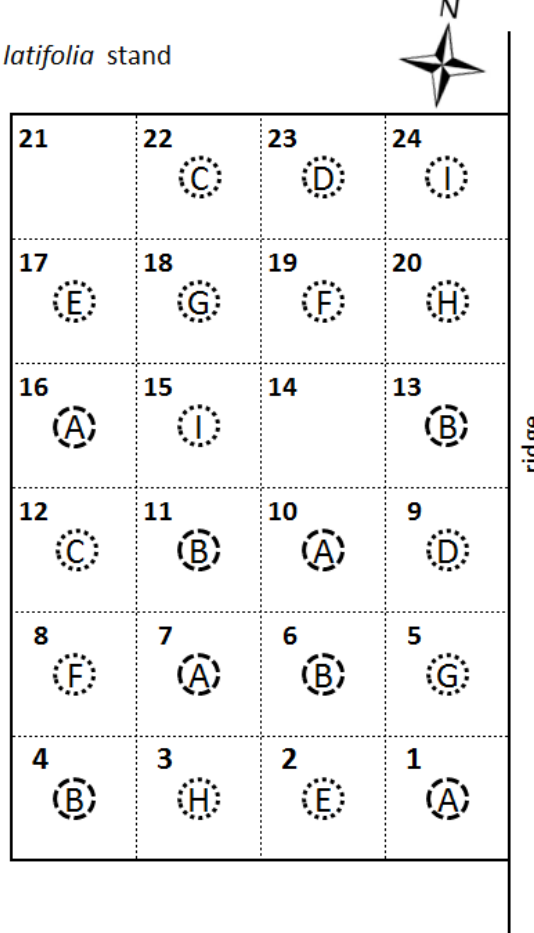
Figure 2. Experiment II and III. Schematic overview of experimental field (6.4 × 9.6 m) divided into 24 equal plots (1.6 × 1.6 m) used for harvesting T. latifolia biomass. The experimental field was a subfield (~ 0.35 ha) of a planted T. latifolia stand. T. latifolia plants surrounded the experimental field on the north, west and south sides. On the east side of the field there was a soil ridge. Harvested surfaces were circles of 0.79 m 2 per plot (0.5 m radius). Plots with letters A and B (dashed circles) were used for Experiments II and III. Plots with letters C–I were only used for Experiment II (dotted circles). Plants outside the harvested surfaces (circles) were not harvested during 2017. Two subplots (nos. 14 and 21) were not used for the experiments. Harvest dates were 19 May (A, B), 02 June (C), 09 June (A), 16 June (D), 30 June (A, B, E), 21 July (A, F), 11 August (A, B, G), 01 September (A, H) and 22 (A, B, I) September